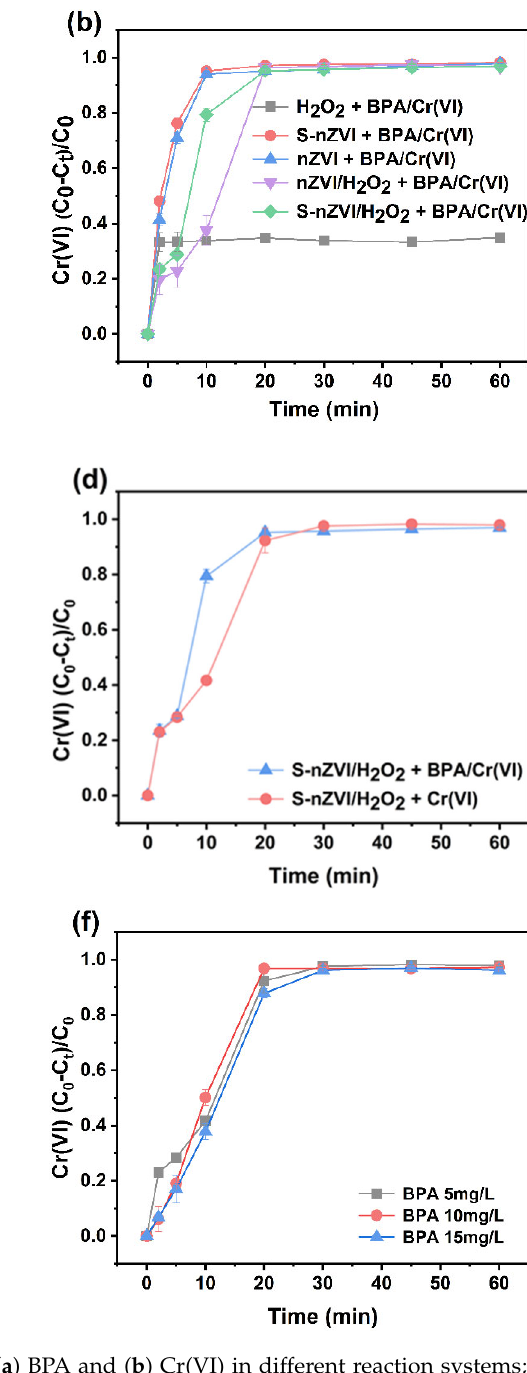
Figure 1. Synchronous removal of ( a ) BPA and ( b ) Cr(VI) in different reaction systems; removal of BPA ( c ) or Cr(VI) ( d ) alone by S-nZVI/H 2 O 2 ; the degradation of BPA under different Cr(VI) concentrations ( e ) and the reduction of Cr(VI) at different BPA concentrations ( f ).